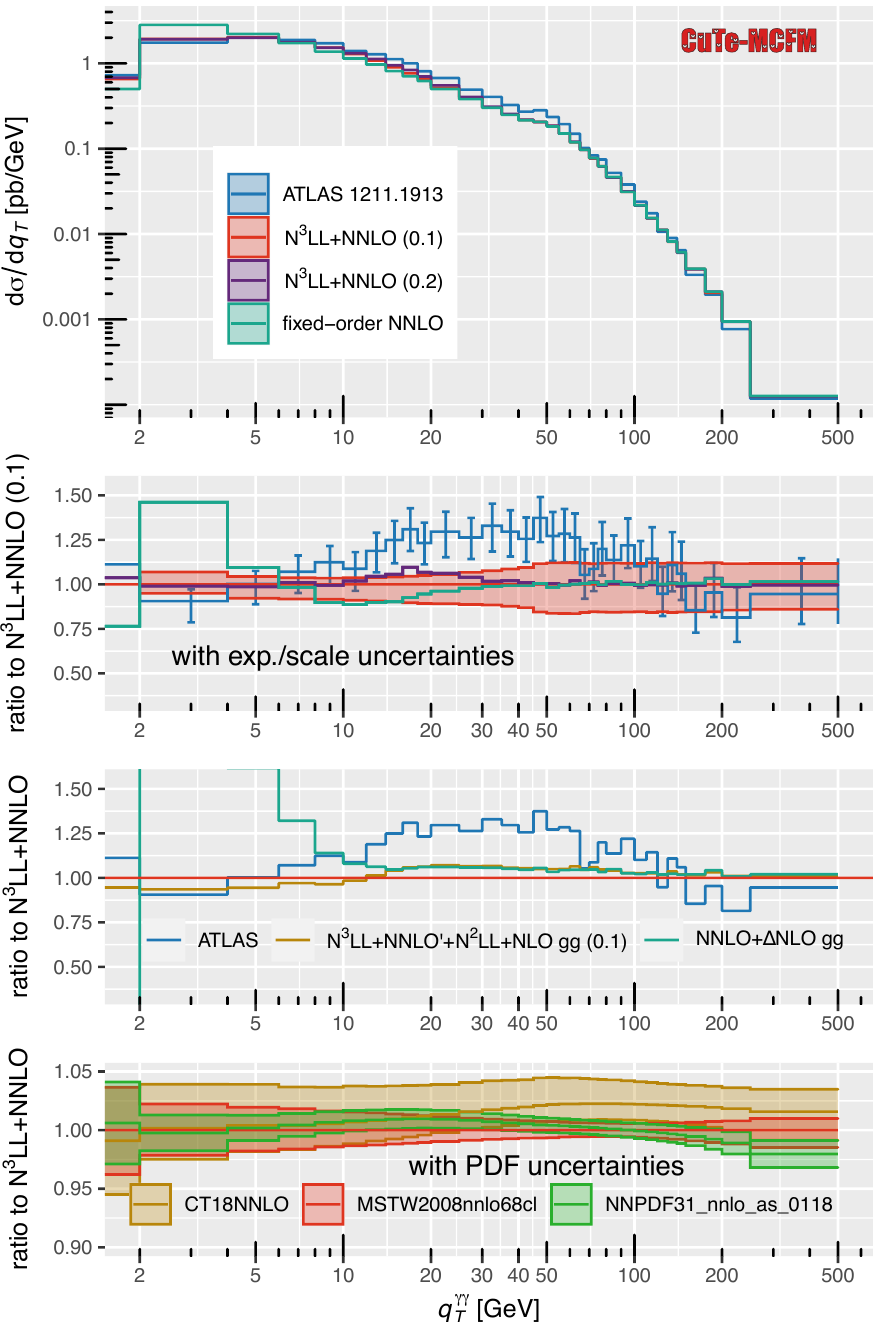
Figure 17. Comparison of 7 TeV ATLAS diphoton results with predictions in various approxima- tions including uncertainties associated with scale variation, PDF s and NLO contributions to the gluon-gluon channel; see text for details. The labels 0 . 1 and 0 . 2 in the plots refer to the value of x max